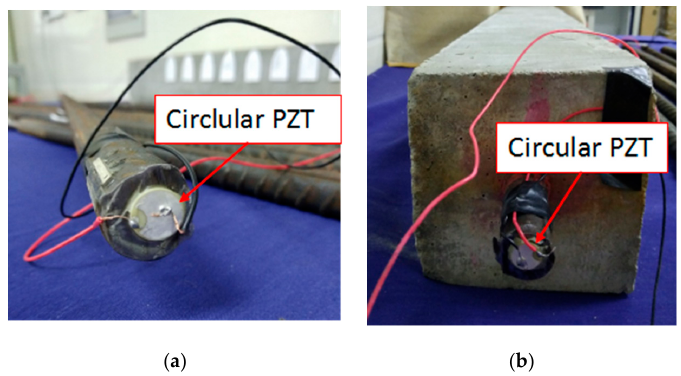
Figure 8. Piezoceramic transducers on the steel reinforced concrete. ( a ) Feature of the piezoceramic transducers attachment. ( b ) Placement of the ultrasonic probe.